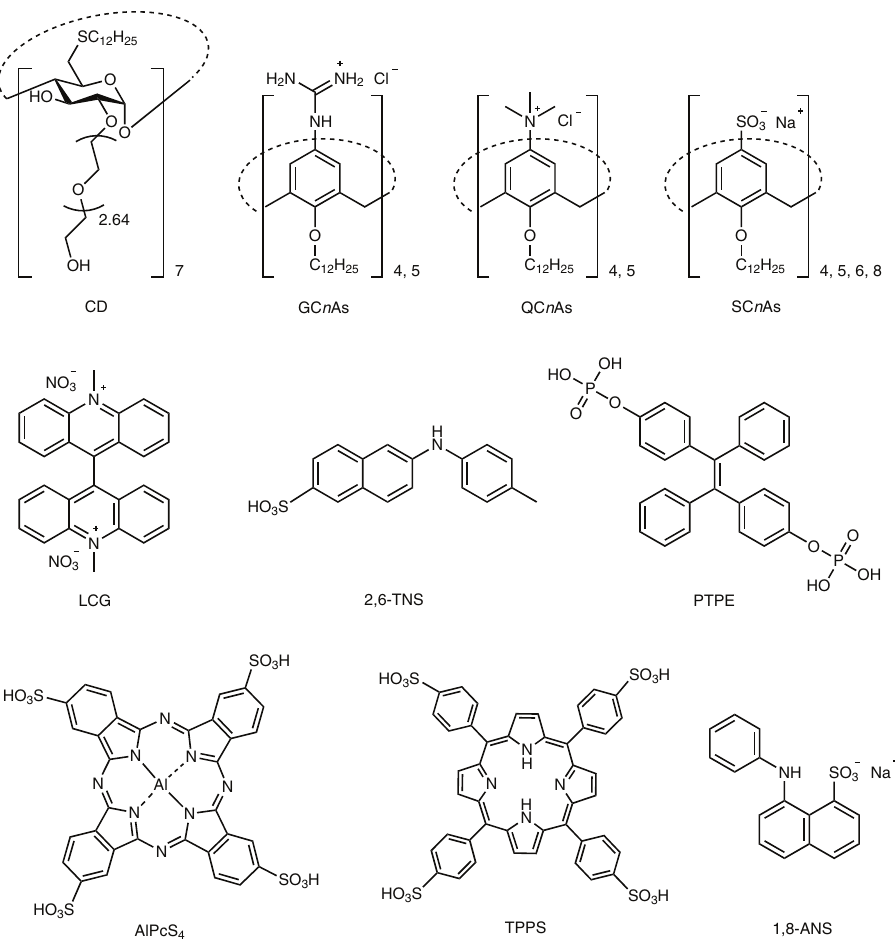
Fig. 2 Chemical structures of CD, CAs, and dyes. Chemical structures of the employed CA (GC n As, QC n As, and SC n As) and CD hosts, and the reporter dyes (LCG, 2,6-TNS, PTPE, AlPcS 4 , TPPS, and 1,8-ANS) in this